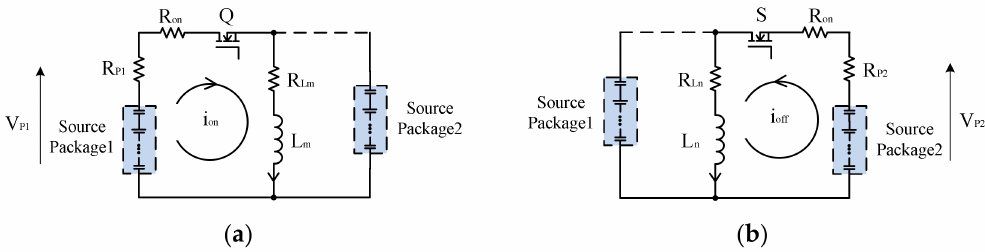
Figure 6. Equivalent Model of the balance circuit. ( a ) on-state; ( b )